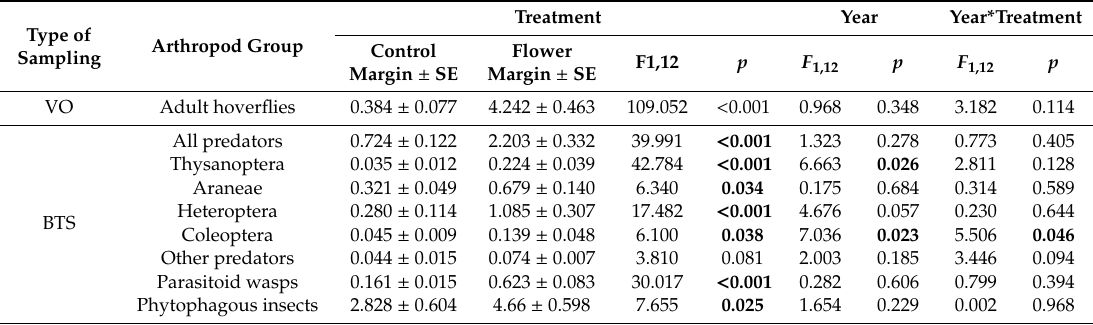
Table 1. Number of natural enemies ( ± Standard Error) assessed during all the sampling period in the visuals observations (VO, number / 1 m 2 × 3 min) and the beating tray samplings (BTS, number / 1 m 2 ) of the